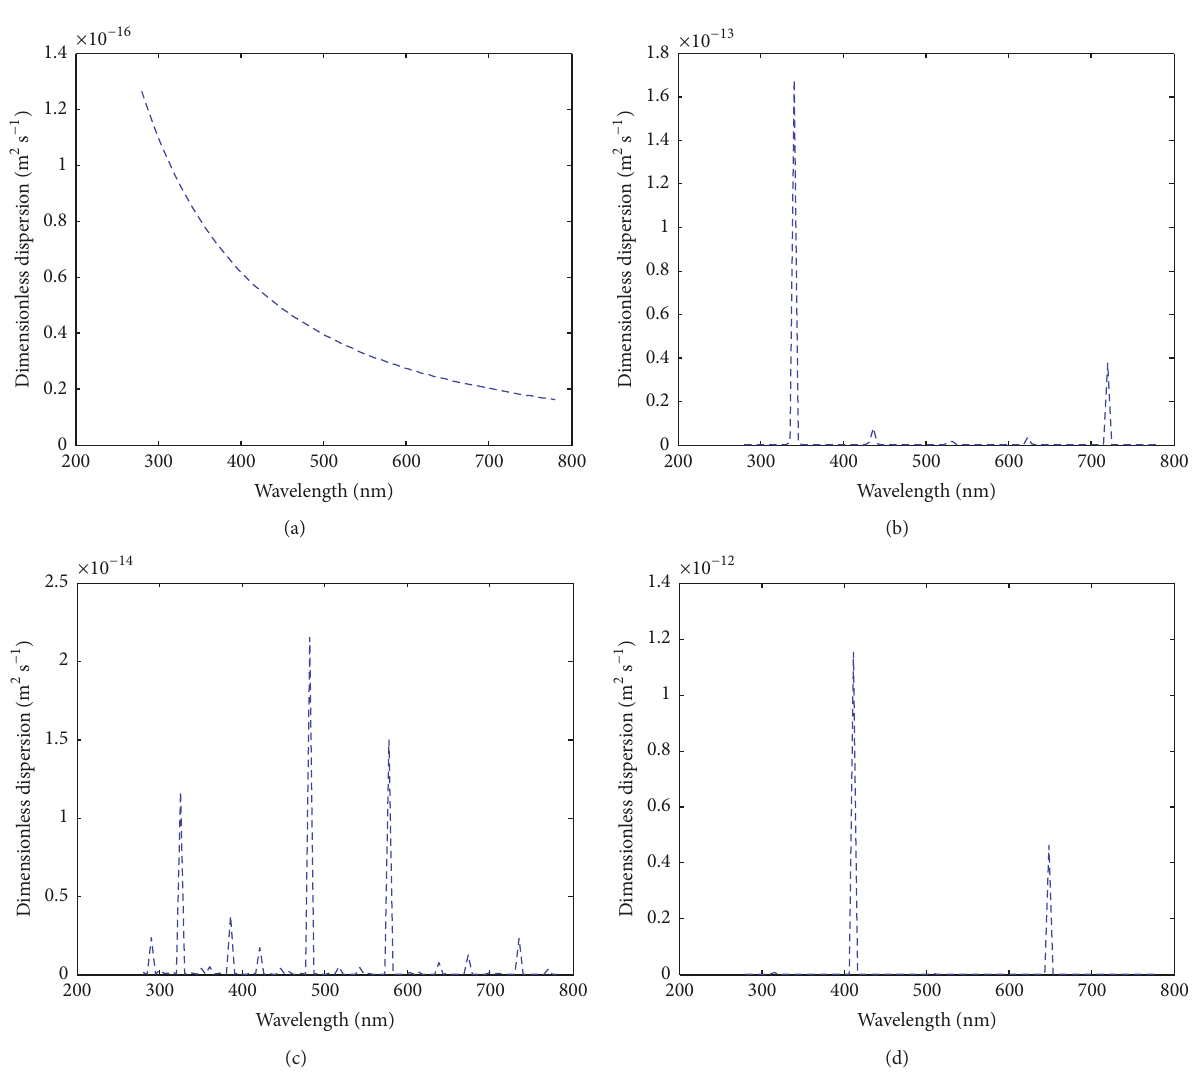
Figure 9: The dimensionless dispersion of the metallic nanoparticle under varying conditions at diameter greater than 10 −9 nm (a) when Bragg’s angle of the nanoparticle is strictly 45 ∘ ; (b) when Bragg’s angle of the nanoparticle ranges between − 30 ∘ and 30 ∘ ; (c) when Bragg’s angle of the nanoparticle ranges between − 45 ∘ and 45 ∘ ; (d) when Bragg’s angle of the nanoparticle ranges between − 60 ∘ and 60 ∘